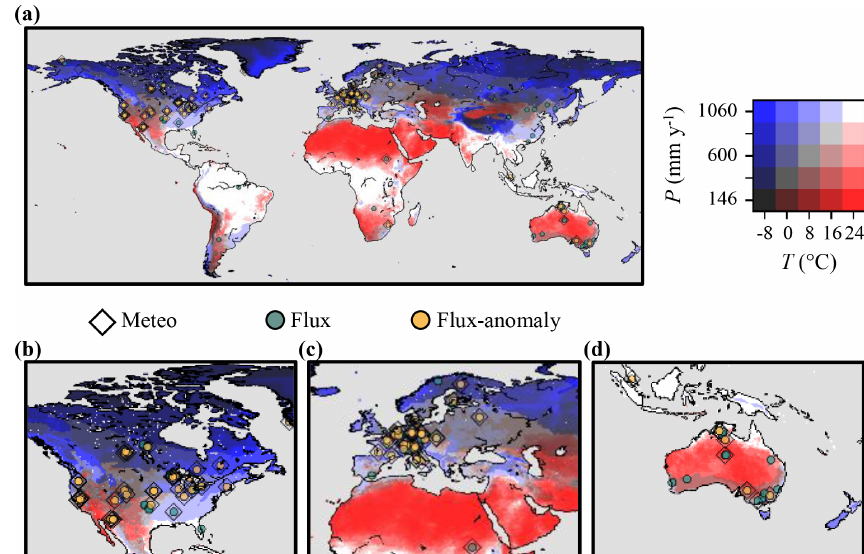
Figure 1. (a) Location of the selected eddy-covariance sites. The lower panels show a detailed view of the sites across the CONUS (b) , Europe (c) , and Australia (d) . Sites with a record length of less than 5 years (i.e. where no anomalies are calculated) are plotted in green and sites with a record length of more than 5 years (i.e. where anomalies are calculated) are plotted in yellow. Sites where measurements of meteorological data are also available are indicated with a diamond. The background provides information on the climatological mean temperature and precipitation derived from ERA5